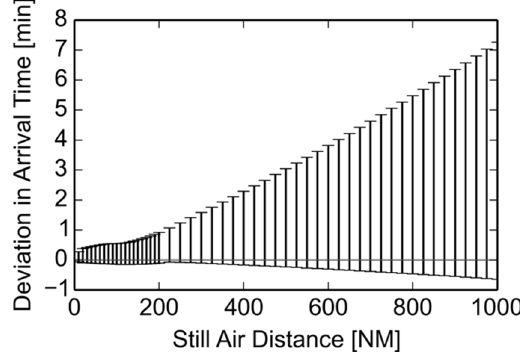
Figure 10. Linearly increasing deviation (minimum and maximum values minus mean values) in the arrival time at certain still air distances compared to the nominal trajectory (grey). During climb, the deviation in arrival time nonlinearly depends on ATOM, because the top of the climb depends on ATOM.